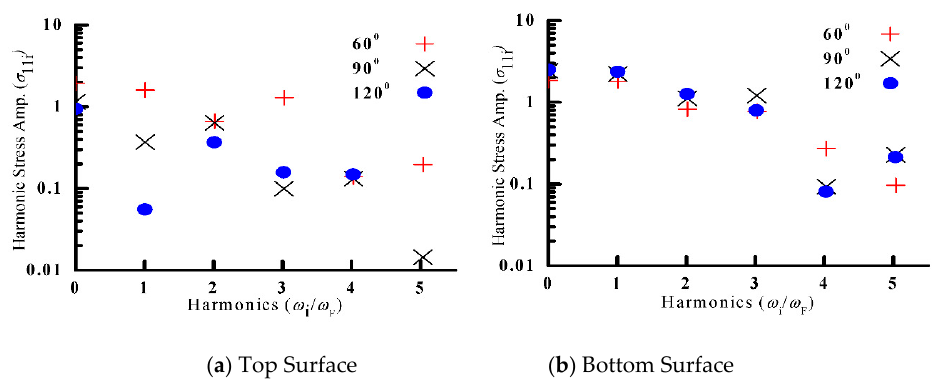
Figure 9. FFT of the steady state stress corresponding to Figure 6.